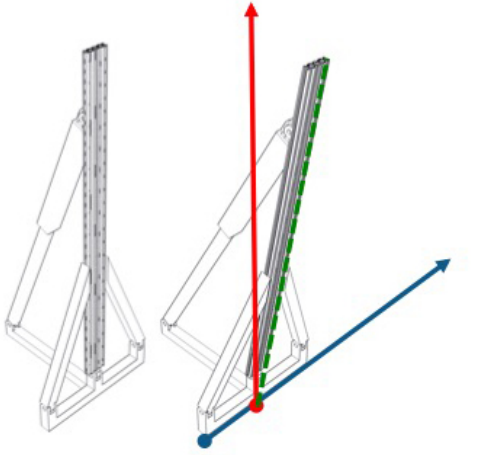
Figure 4: Schema of the versatile mechanical structure showing XY (blue/red) translation and X (green) rotation system